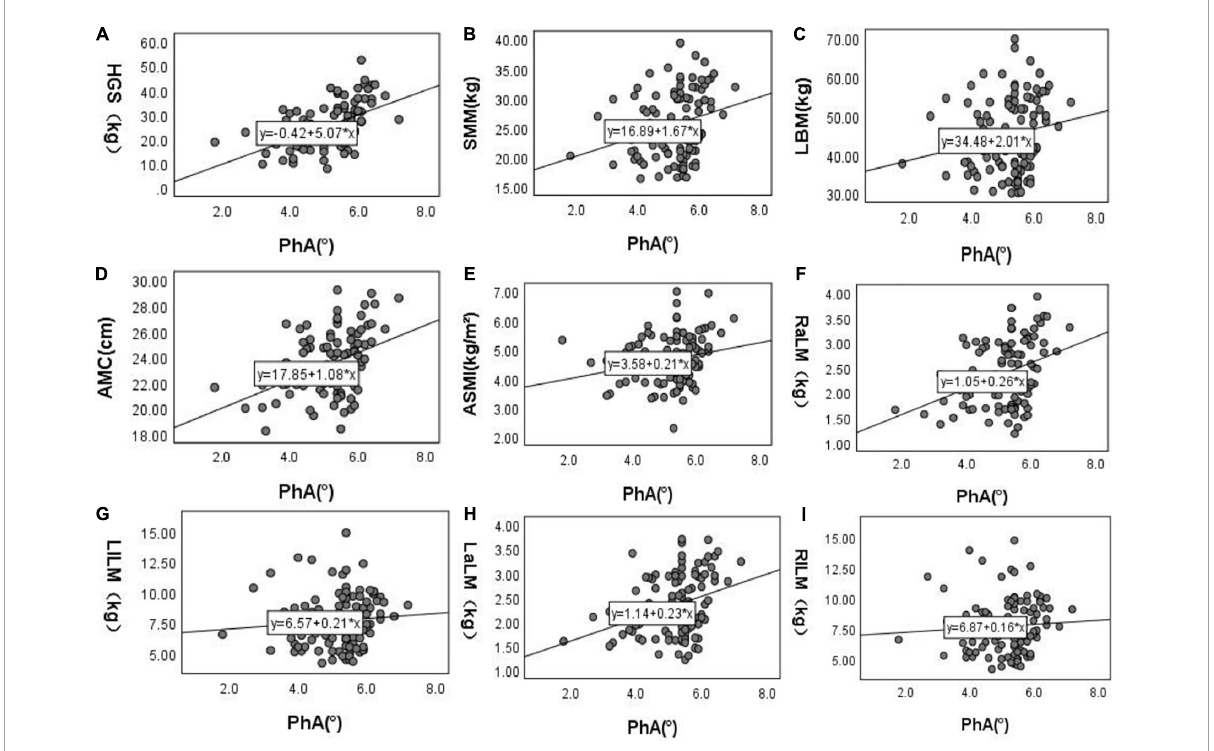
FIGURE1 Scatter plots of PhA and related